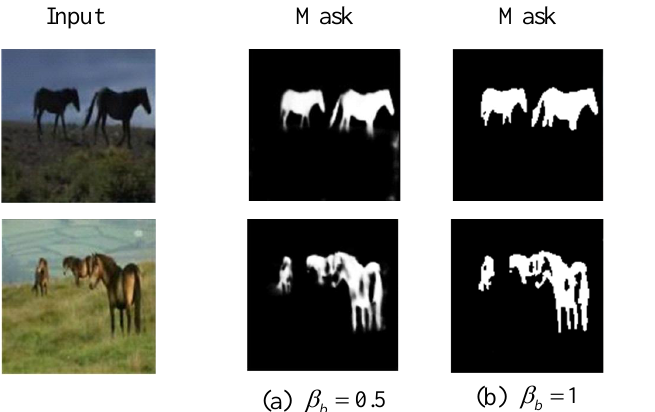
Figure 7. The experimental results of different β b for the binary loss. The binary mask is obtained when β b is 1.